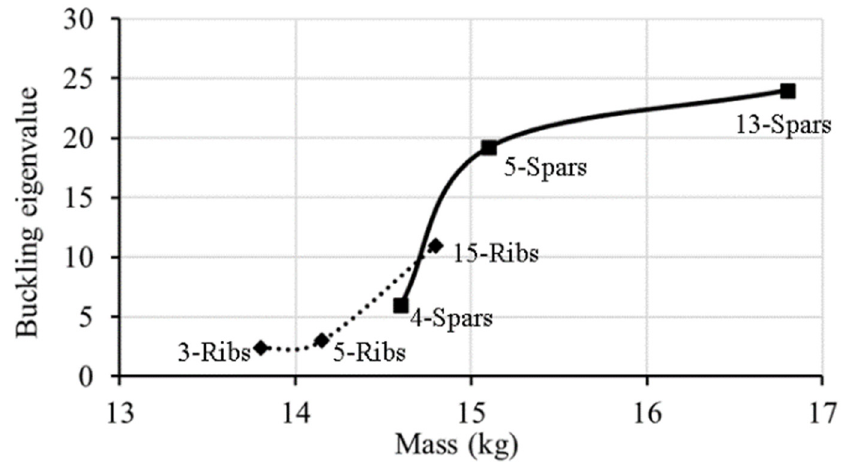
Figure 10. Comparison of buckling eigenvalue in terms of mass between multi-spar and multi-rib configurations.